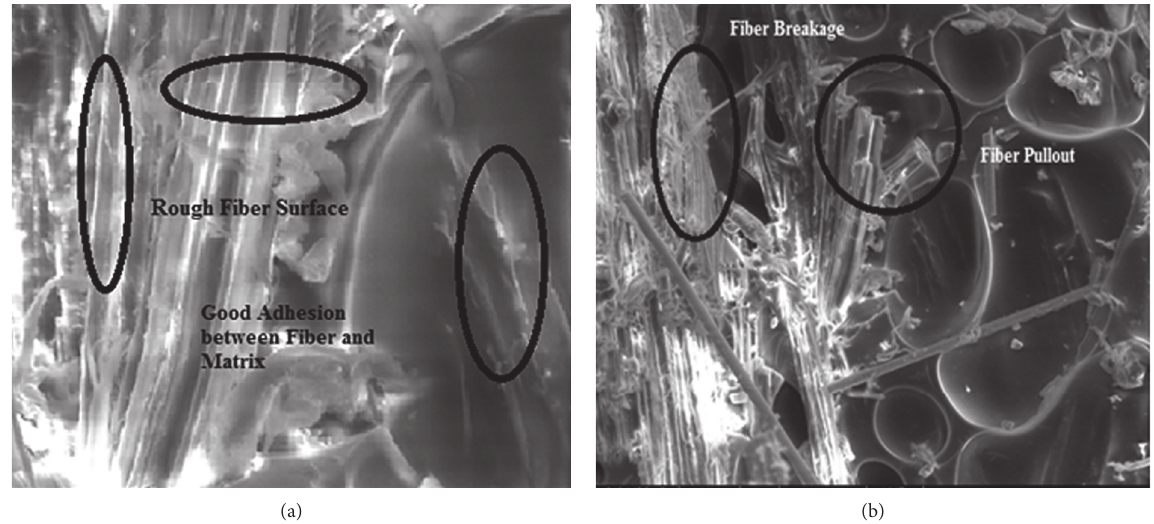
Figure 4: SEM images: (a) 20% wt. of snake grass fiber-reinforced composite; (b) 25% wt. of snake grass fiber-reinforced composite.